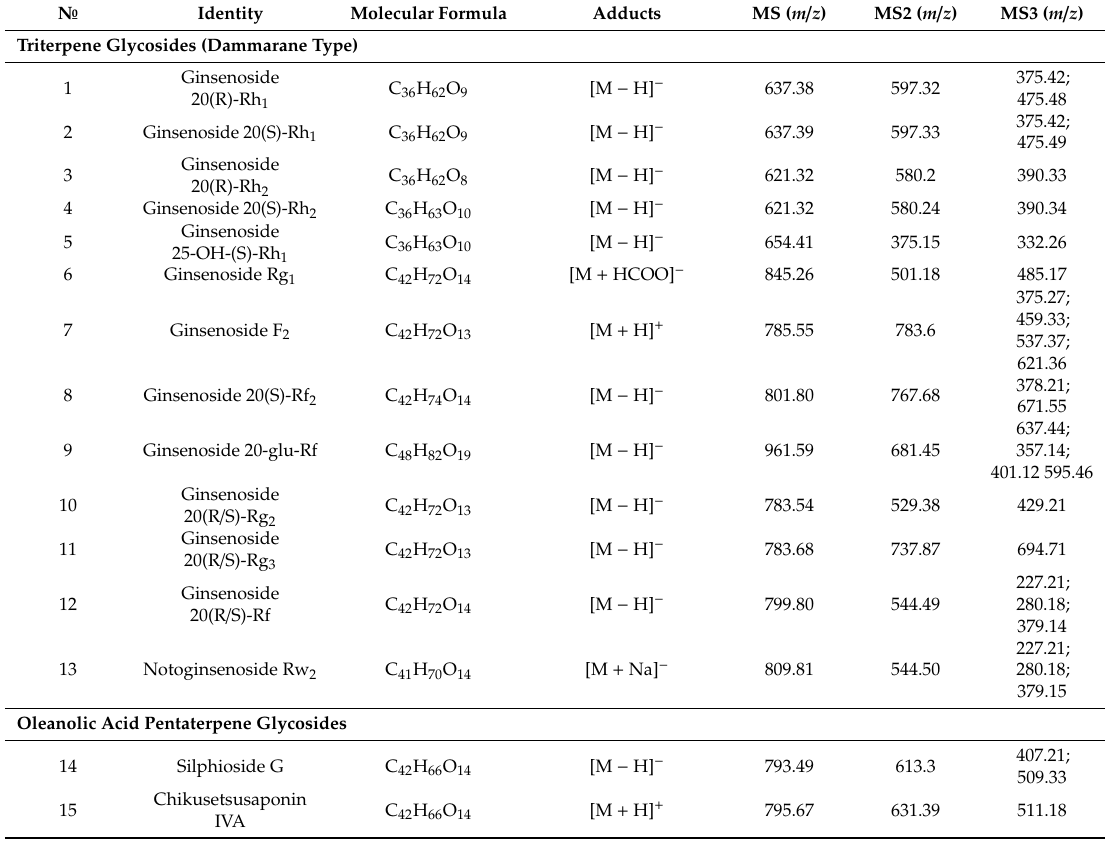
Table 2. Components identified from the supercritical extract of P. ginseng (North Korea, Kaesong). № Identity Molecular Formula Adducts MS ( m / z ) MS2 ( m / z ) MS3 ( m / z ) Triterpene Glycosides (Dammarane